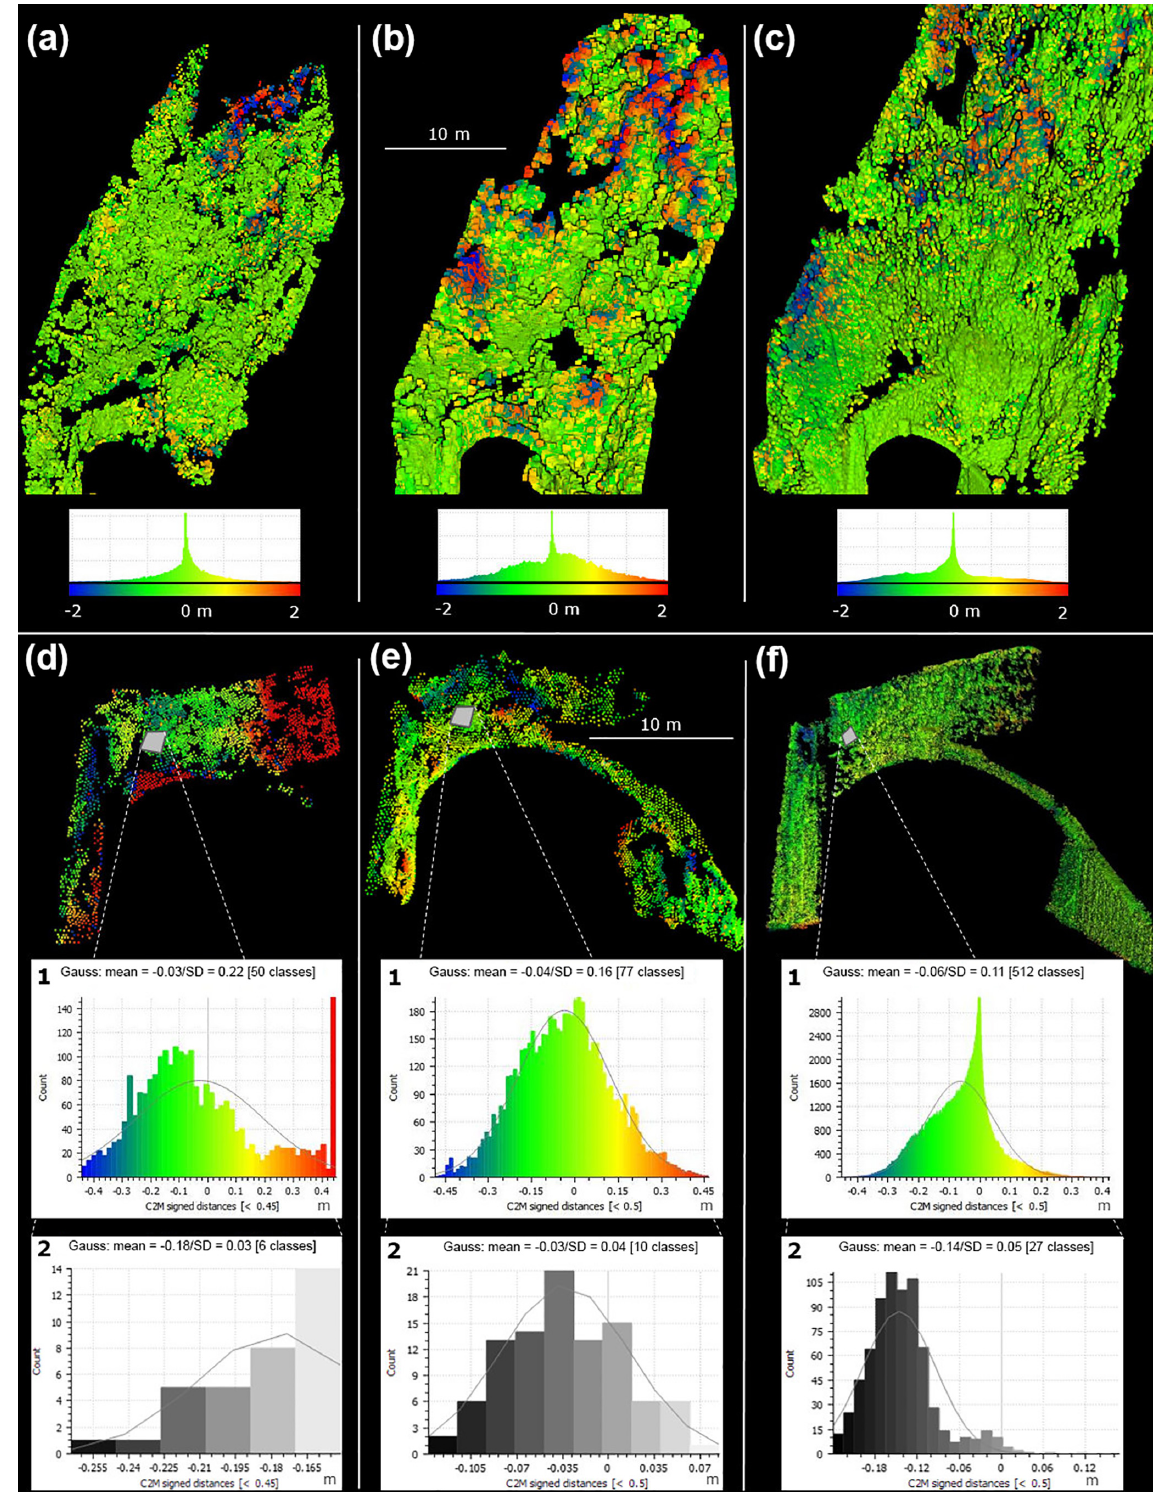
Figure 7. (a–c) March 2010, July 2014 and August 2016 point clouds compared with December 2016 lidar digital elevation model (DEM; red points are material increase; blue points are material decrease from the 2016 lidar cloud) with the point-to-mesh strategy on the Cloud- Compare. (d–f) Tunnel entry and part of the wall overlooking the tunnel (grey polygon) of the March 2010, July 2014 and August 2016 point clouds compared with December 2016 lidar DEM. The information on the picture source, date, point density and program used is given in Tables 1 and